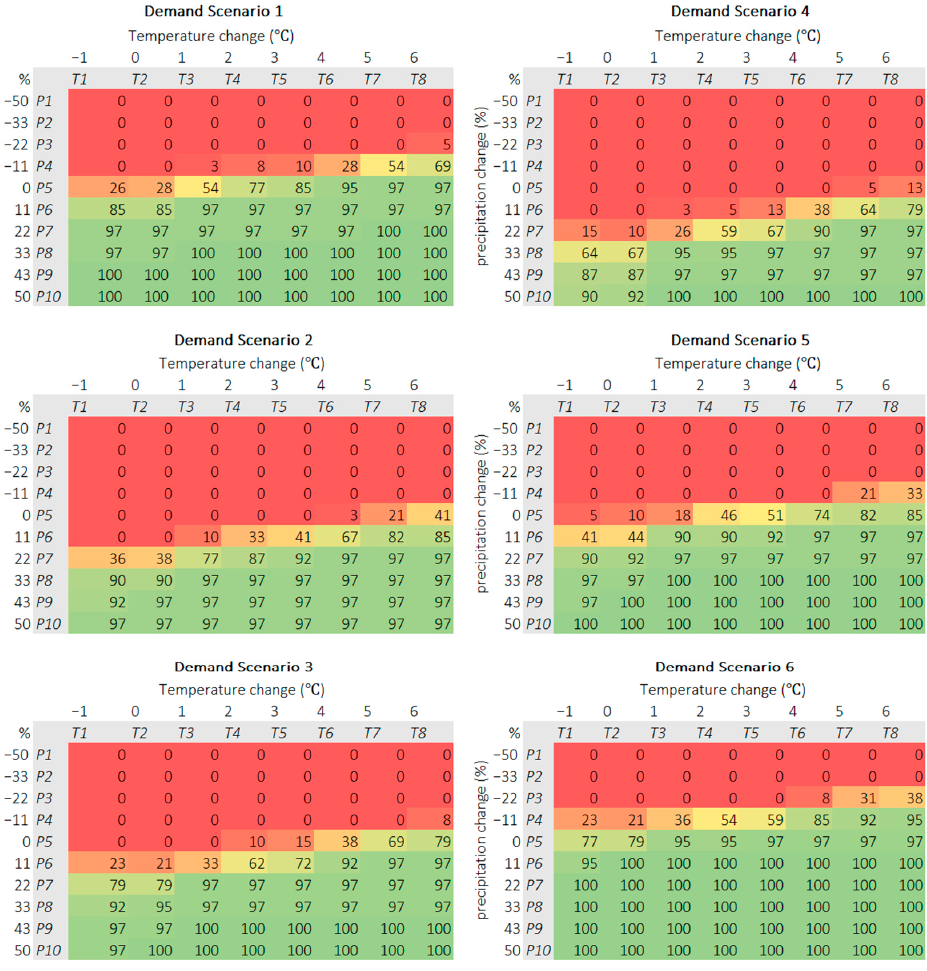
Figure 7. Surface response tables of reliability of flows to the lower Ili, expressed as the percentage (%) of years per model run meeting the environmental requirement of 11 BCM per year, with the green to red gradient indicating high to low